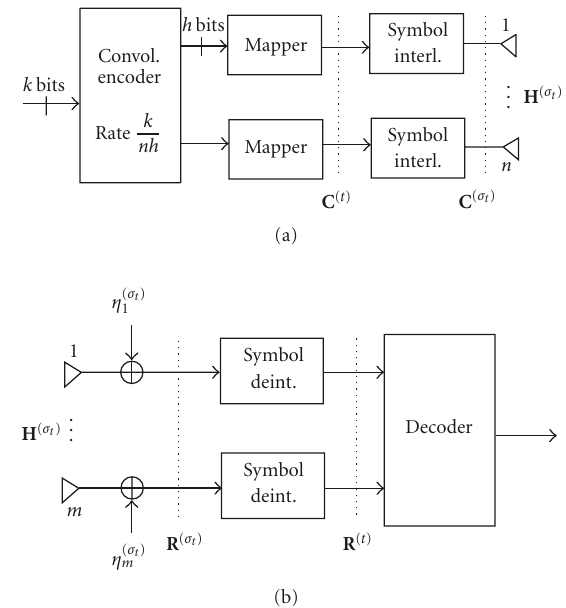
Figure 2: Architecture of pragmatic space-time codes. For coop- erative P-STCs, the “distributed” convolutional encoder is the ensamble of R + 1 single encoders, one for each transmitter; hence, instead of n , we must consider the overall number of antennas ( R + 1) n .